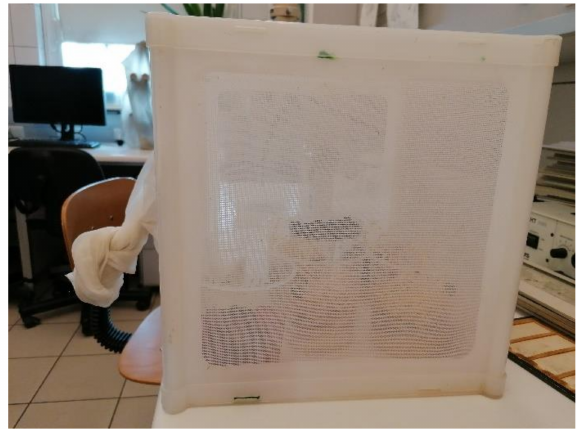
Figure 1. Rearing container with fertilized females of D. suzukii .